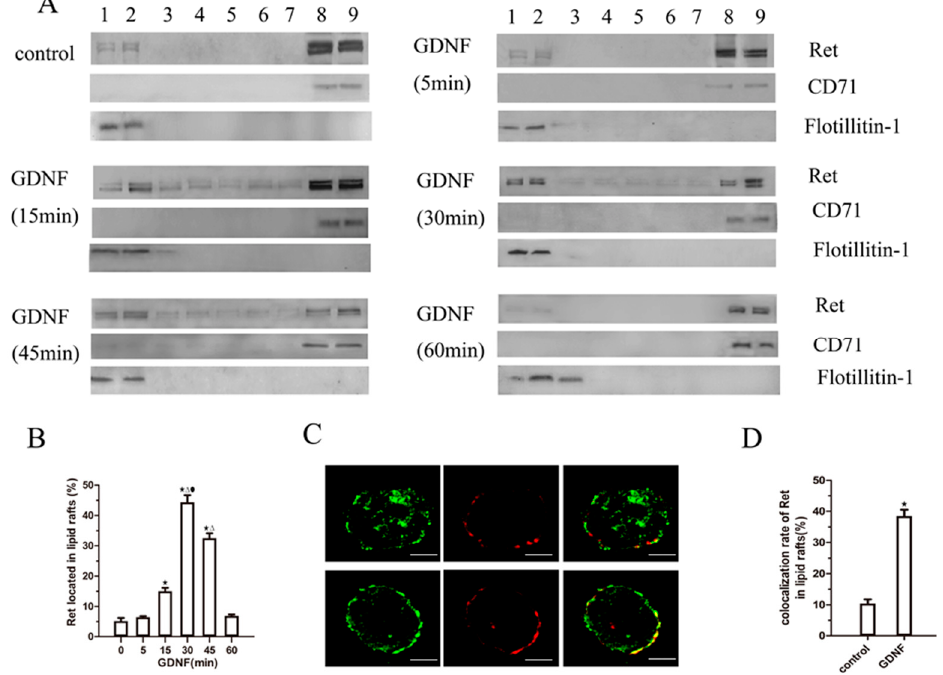
Figure 2. Ret associates with lipid raft fractions after GDNF stimulation. ( A , B ) Differentiated MN9D cells were treated with medium alone or with GDNF (50 ng/mL) for 5, 15, 30, 45, and 60 min, respectively. The cells were then lysed and subjected to OptiPrep™ density centrifugation as described in the methods. Nine equal fractions were obtained and labeled from 1 to 9. These fractions were analyzed by western blotting for Ret, flotillin-1, and CD71. The data were represented as means ± SEM of three independent experiments. ★ p < 0.05 vs. 0 min, Δ p < 0.05 vs. 15 min, ● p < 0.05 vs. 45 min; ( C , D ) Differentiated MN9D cells were treated with medium alone or with GDNF (50 ng/mL) for 30 min. Then lipid rafts (red) and Ret (green) patching was induced as described in the methods. Confocal microscopy was used to detect the colocalization of lipid rafts and Ret. The data were represented as means ± SEM of three independent experiments. ★ p < 0.05 vs. 0 min. (Scale bar = 5 μ m).